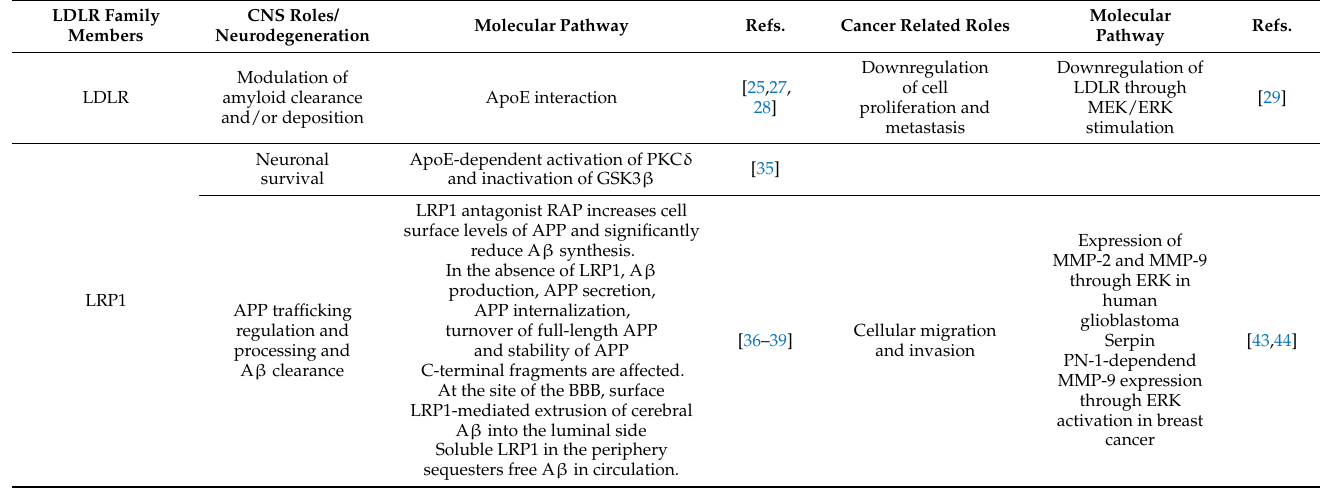
Table 1. CNS/neurodegeneration and the cancer-related roles of the LDL receptors. The table summarizes roles and relative molecular pathways of all LDLR (except LRP8, which is discussed later in detail) in CNS/neurodegeneneration and